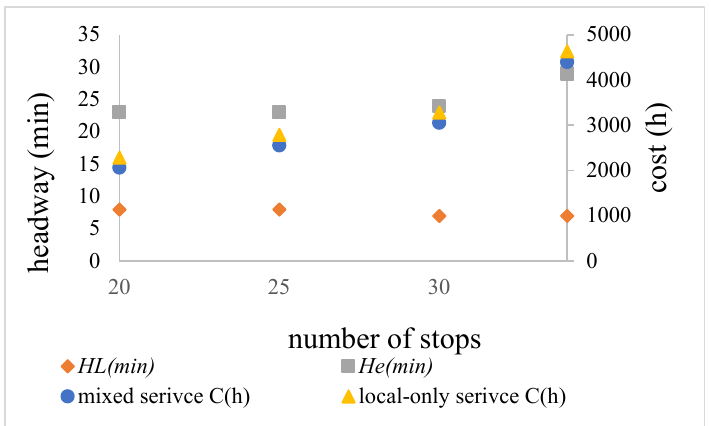
Figure 5. The cost variation in the mixed service and the local-only service with changes to the number of stops.